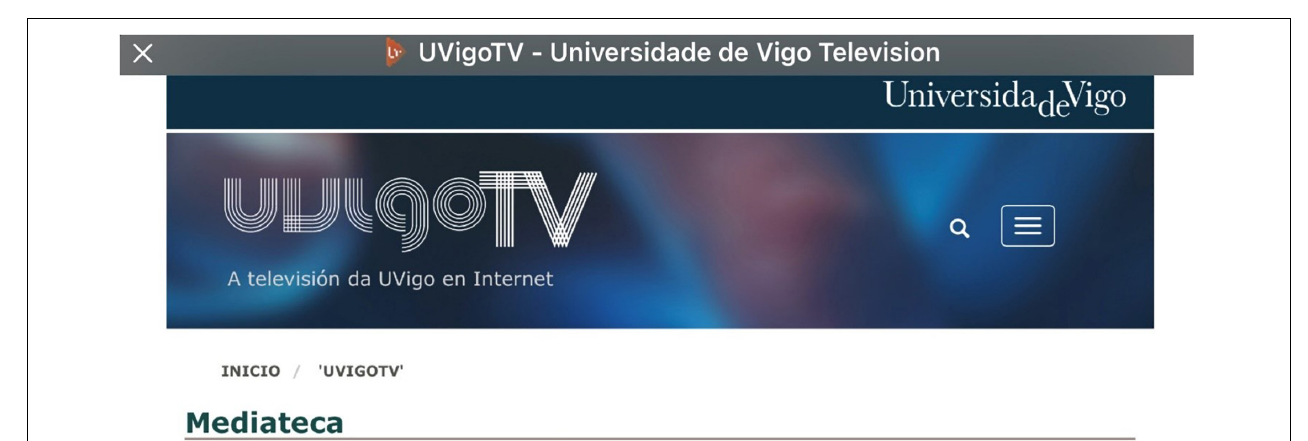
FIGURE 1 | Methodology.